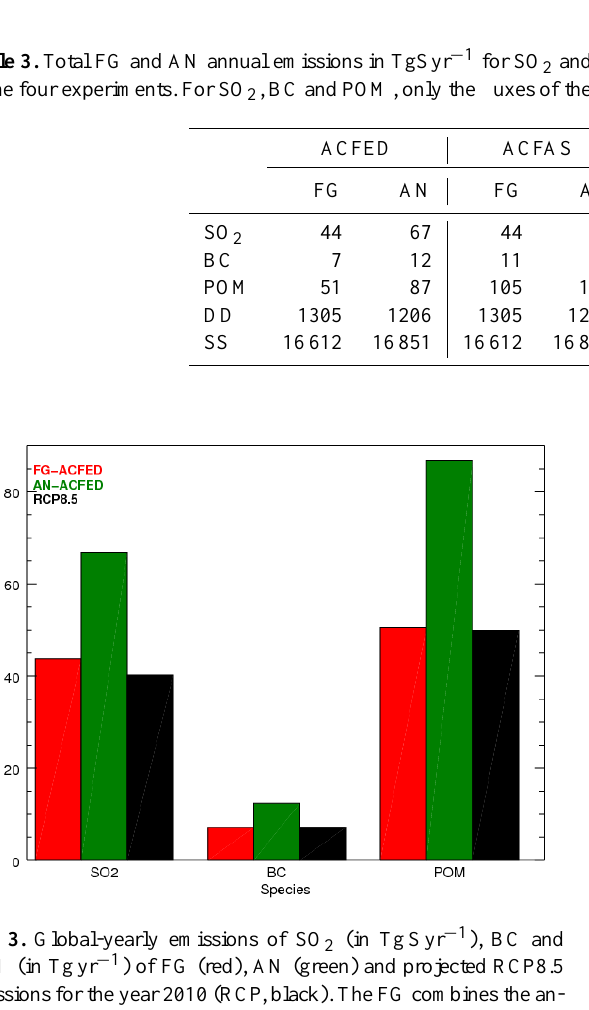
Fig. 4. Same as Fig. 3 but for annual SO 2 emissions in the thirteen regions illustrated in Fig. 1a.